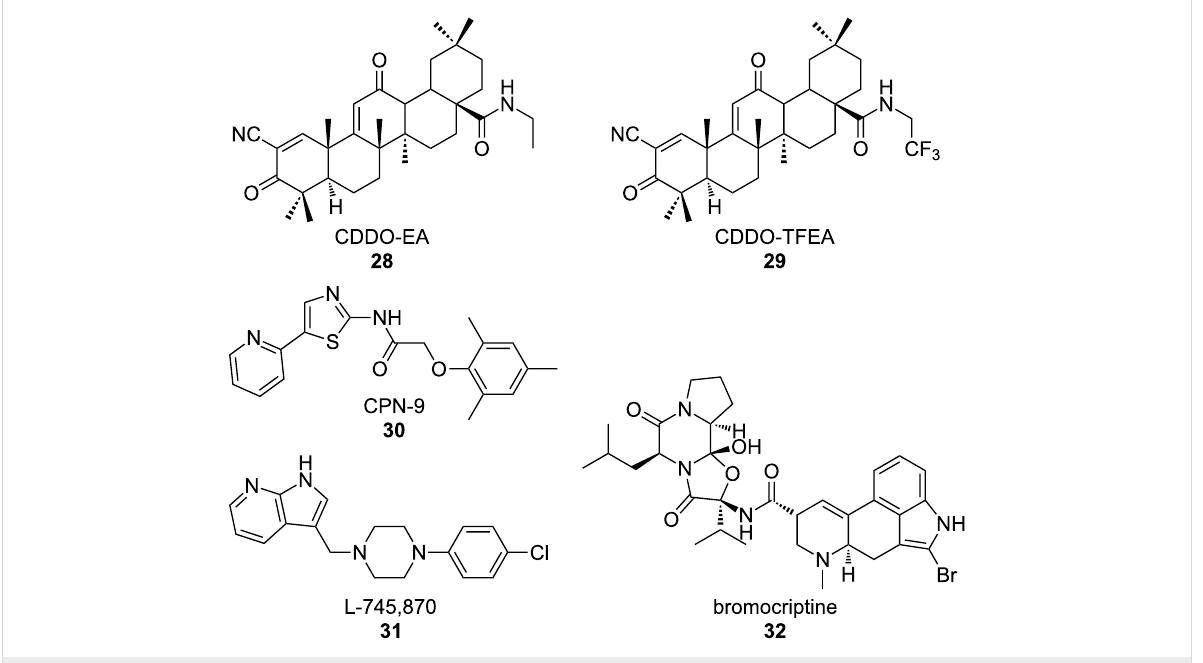
Figure 13: Compounds developed to reduce oxidative stress and inflammation.